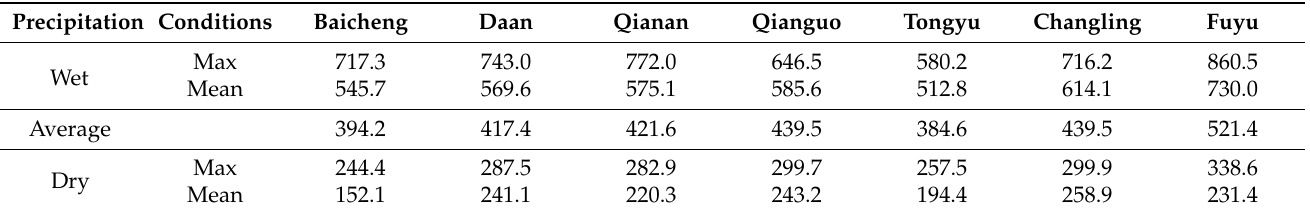
Table 5. Wet-dry division of annual precipitation of seven weather station in western